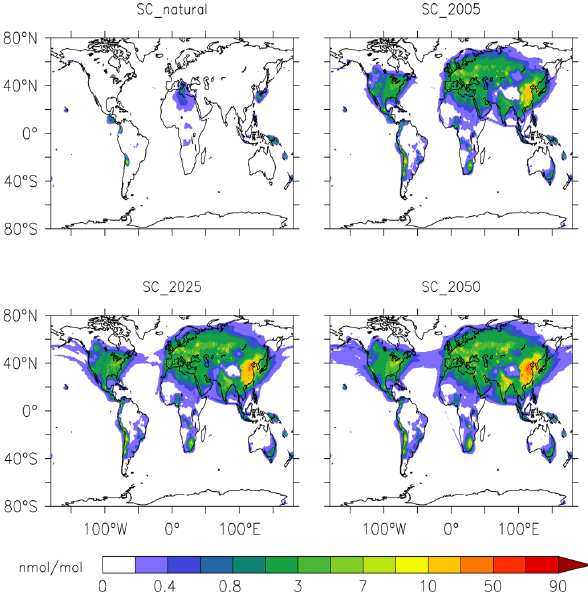
Fig. 4. Model calculated annual mean near-surface ozone in nmol mol − 1 from simulation SC natural , SC 2005 , SC 2025 and SC 2050